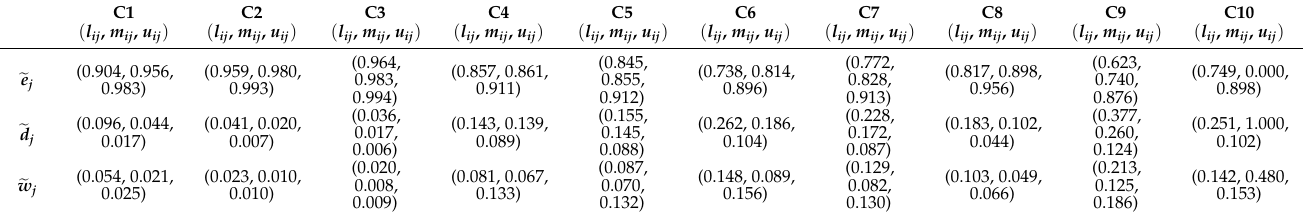
Table 7. The fuzzy Shannon entropy vector, the fuzzy diversification vector, and the fuzzy criteria